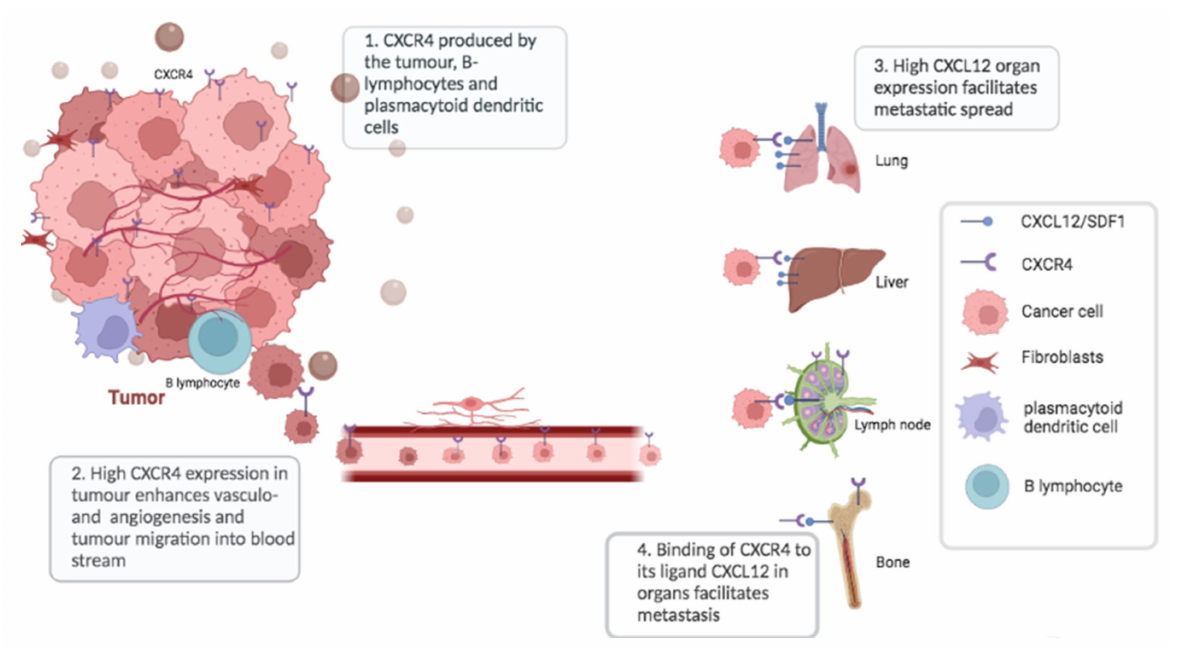
Figure 1. The CXCR4 overexpression in tumours increases angiogenesis, tumour migration and